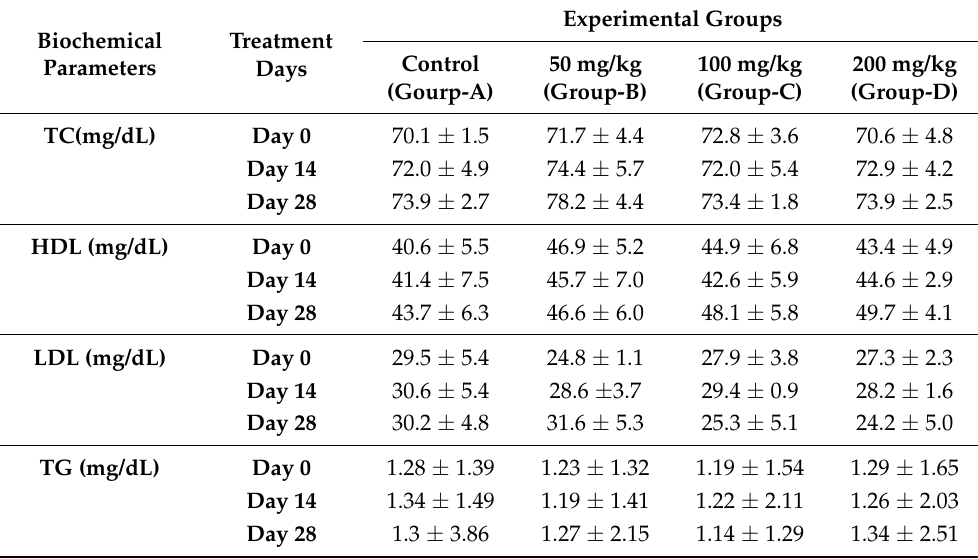
Table 3. Mean serum biochemical parameters of female albino rats exposed to different doses of methanolic seed extract of Azadirachta indica . Experimental Groups Biochemical Treatment Control Parameters Days